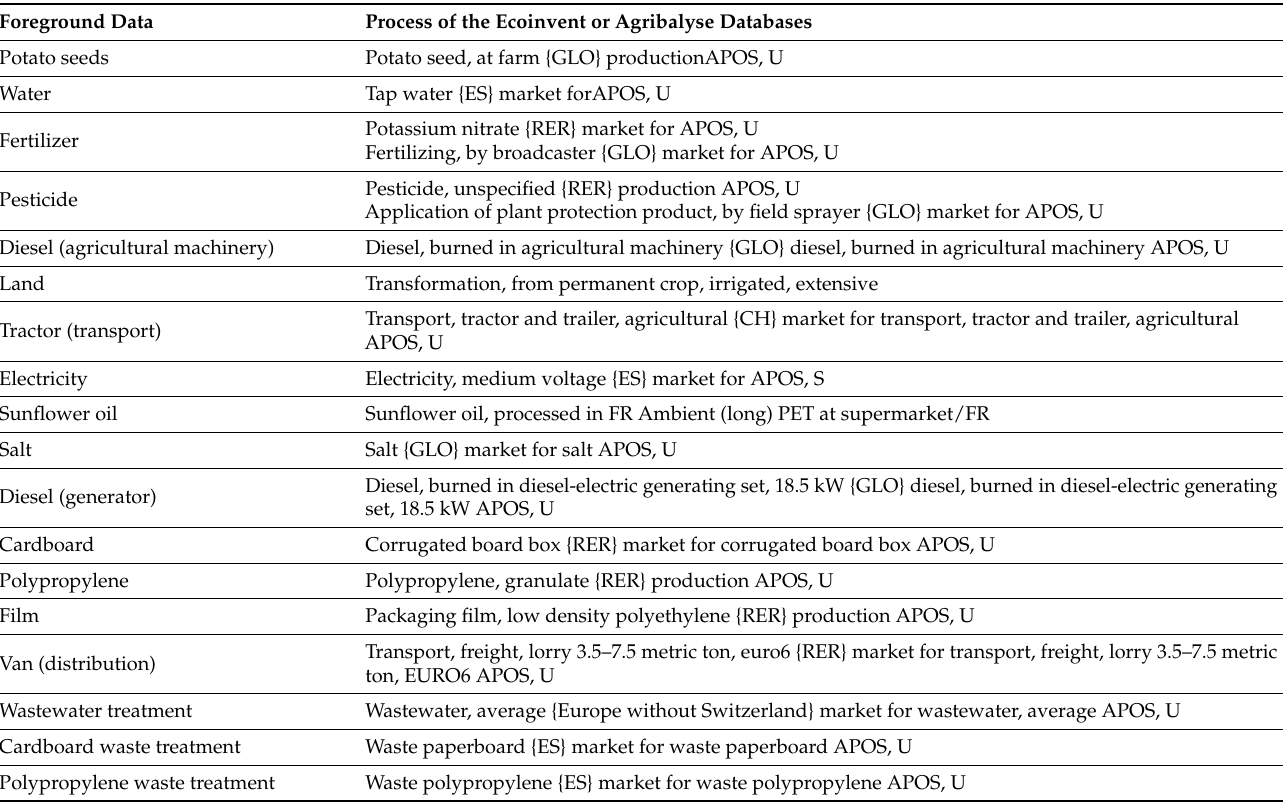
Table A1. Equivalence between foreground data and Ecoinvent and Agribalyse database